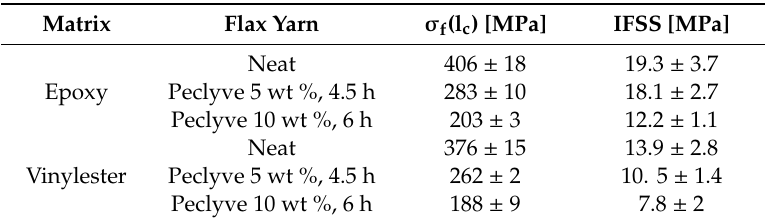
Table 7. Strength values at critical fragment length and interfacial shear strength (IFSS) values for the neat and enzymatically modified flax / epoxy and flax / vinylester